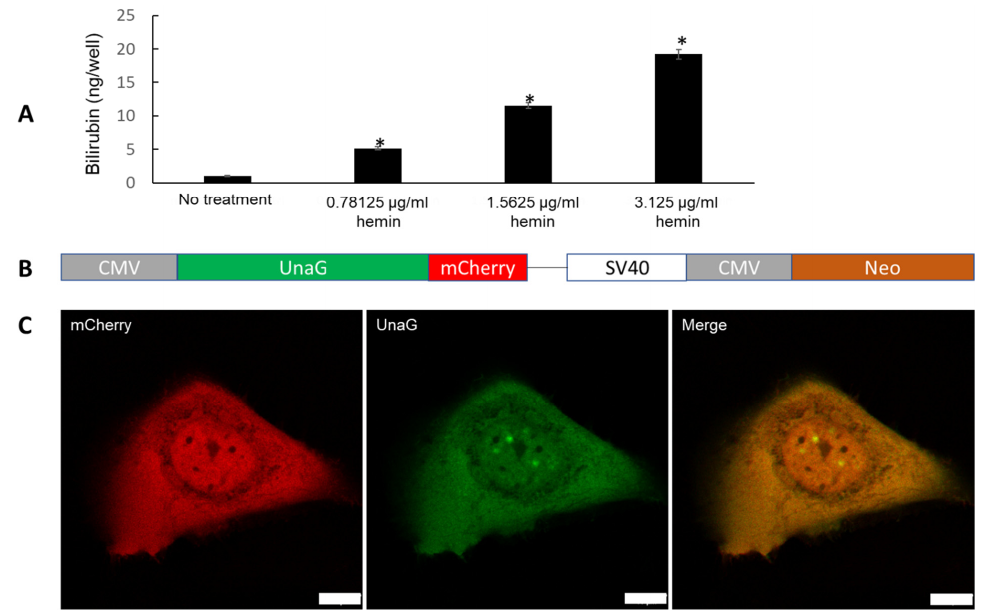
Figure 2. ( A ) Dose–response effect of hemin on de novo bilirubin production in keratinocytes for 48 h. Bar indicates mean ± SEM. *; p < 0.05 vs. no treatment group. ( B ) UnaG-mCherry bilirubin sensor. Observation of mCherry allows identification of transfected and expressing cells in absence of bilirubin-induced UnaG fluorescence and enables signal normalization to correct for cell-to-cell expression variation. ( C ) Human keratinocytes expressing sensors grown and maintained in bilirubin- free EpiLife media. mCherry (red) confirms sensor expression. UnaG fluorescence (green) indicates intracellular de novo synthesis of bilirubin in keratinocytes. Scale = 10 µ m.